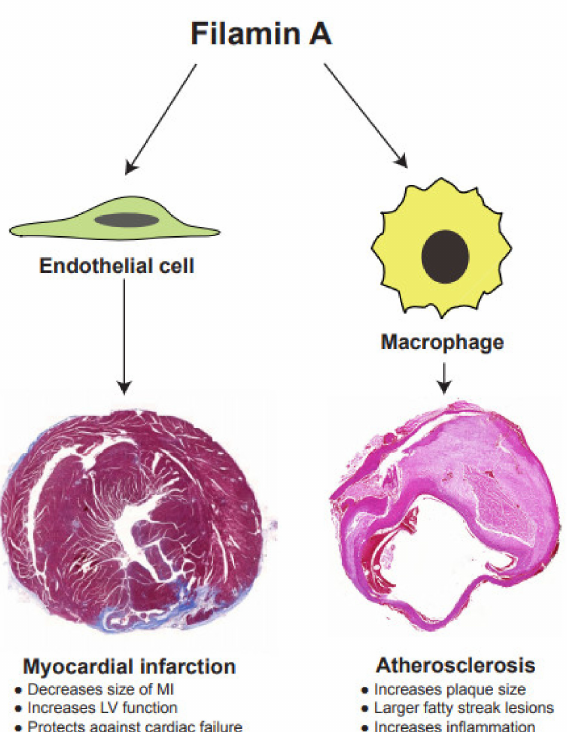
Figure 4. FLNA regulates functions of both endothelial cells and macrophages that are critical for the progression of myocardial infarction and atherosclerosis,